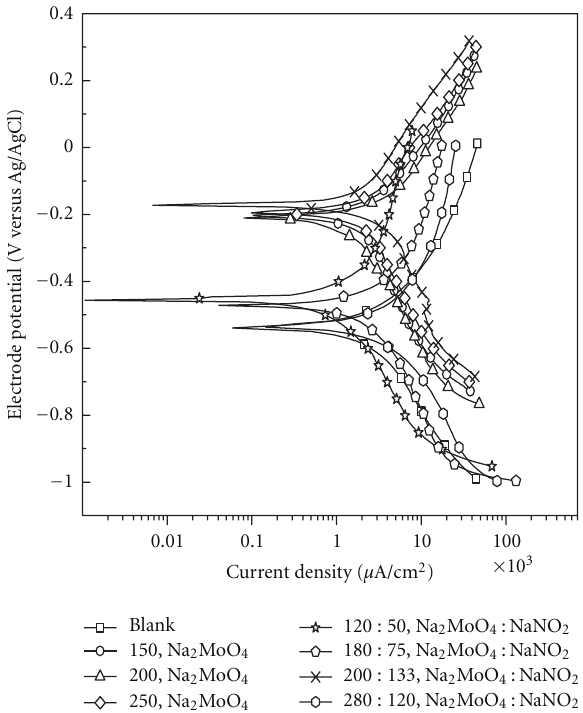
Figure 3: Current-Potential plots varying the concentration ratio Na 2 MoO 4 :NaNO 2 in ppm. Table 1: Current potential data varying the concentration ratio Na 2 MoO 4 :NaNO 2 .